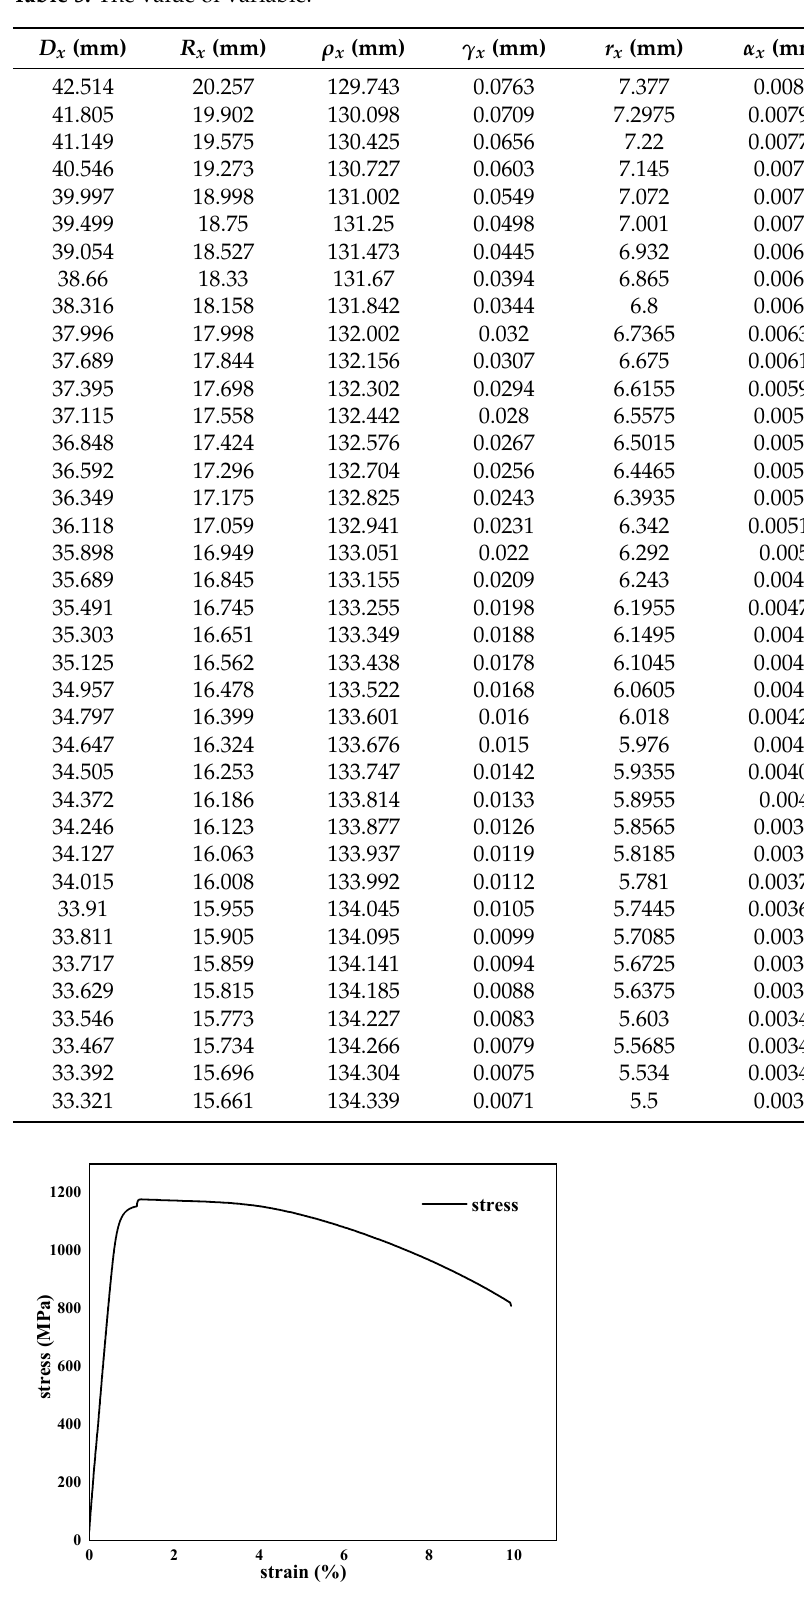
Figure 6. Stress-strain curve of test steel.